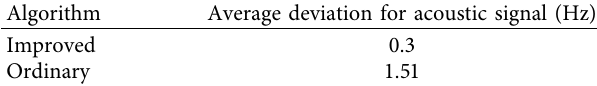
Table 3: The average deviation of two algorithm in experiment. Algorithm Average deviation for acoustic signal (Hz) Improved 0.3 Ordinary